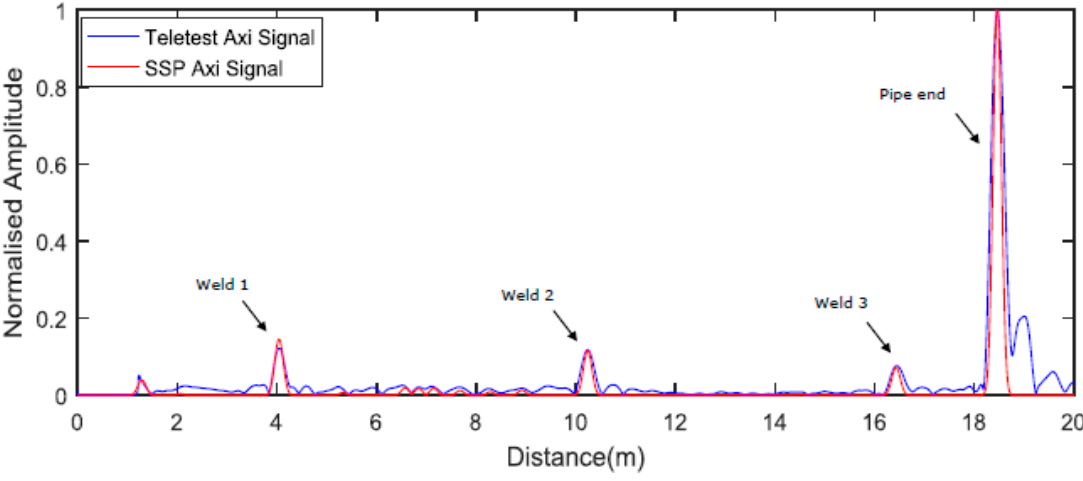
Figure 5. Baseline axisymmetric and SSP signal without coating for 27 kHz.